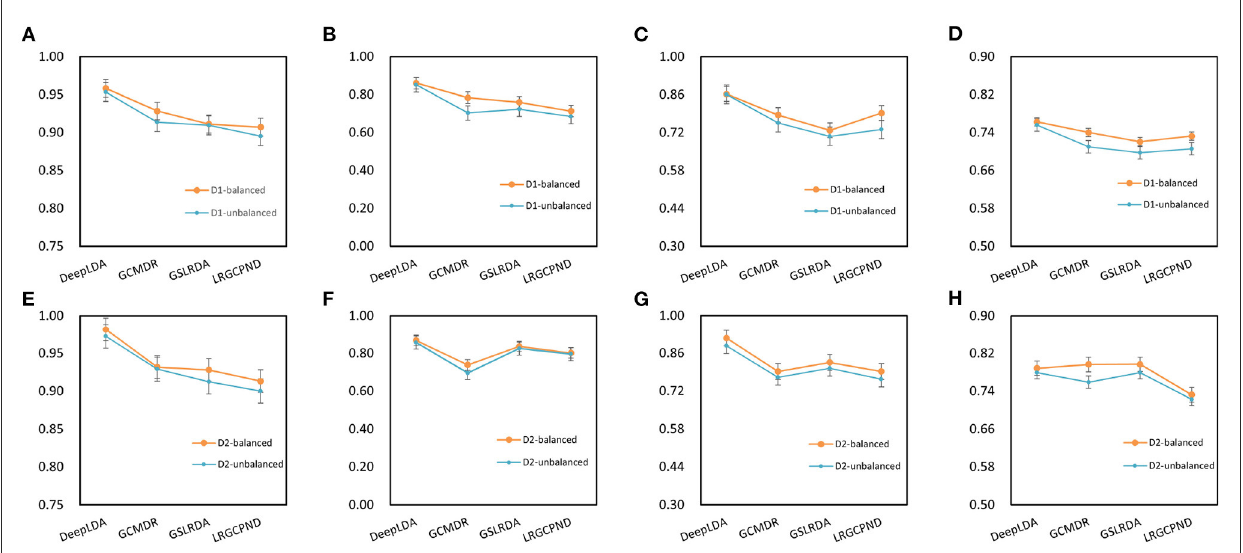
FIGURE5 Performance comparison with other methods. D1 and D2 represent NoncoRNA and ncDR, respectively. (A) AUC on D1. (B) AUPR on D1. (C) F1-score on D1. (D) MCC on D1. (E) AUC on D2. (F) AUPR on D2. (G) F1-score on D2. (H) MCC on D2.